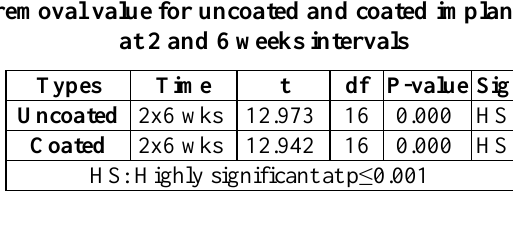
Table 4: t-test for equality of means of